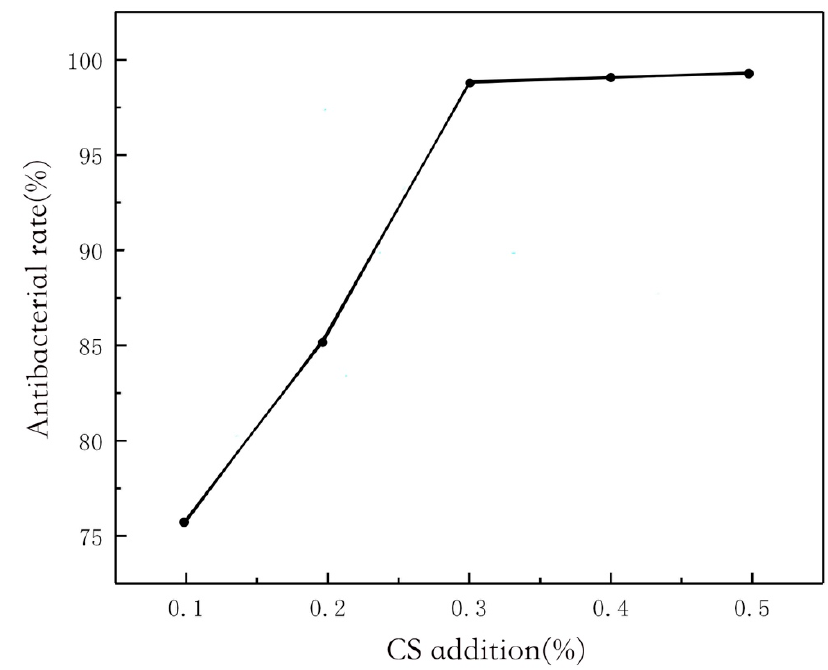
Figure 5. Effect of CS addition on the antimicrobial activity of CS/Gr modified bamboo fiber fabrics (CGBFs).